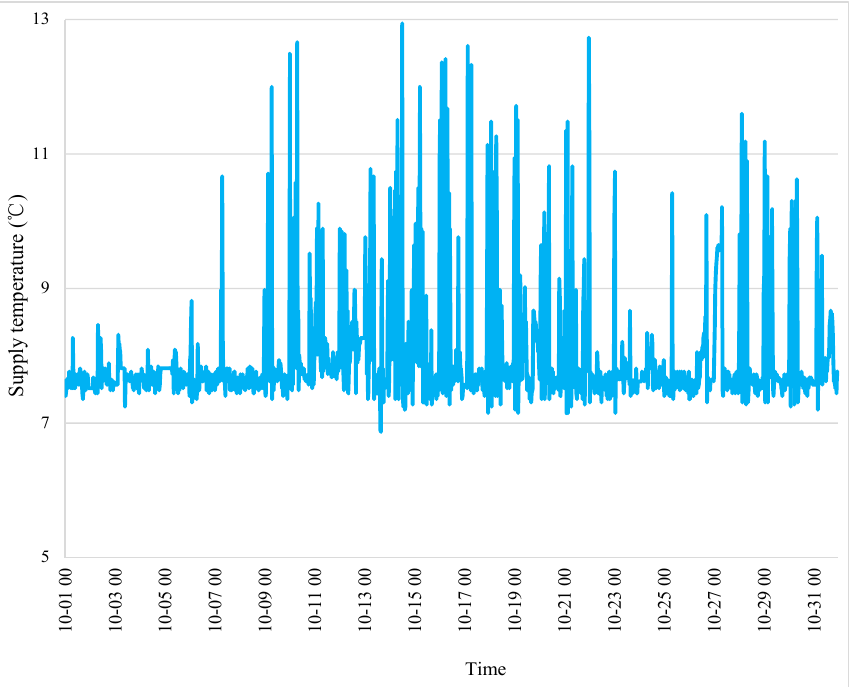
Figure 7. Actual supply temperature of the chilled water system.